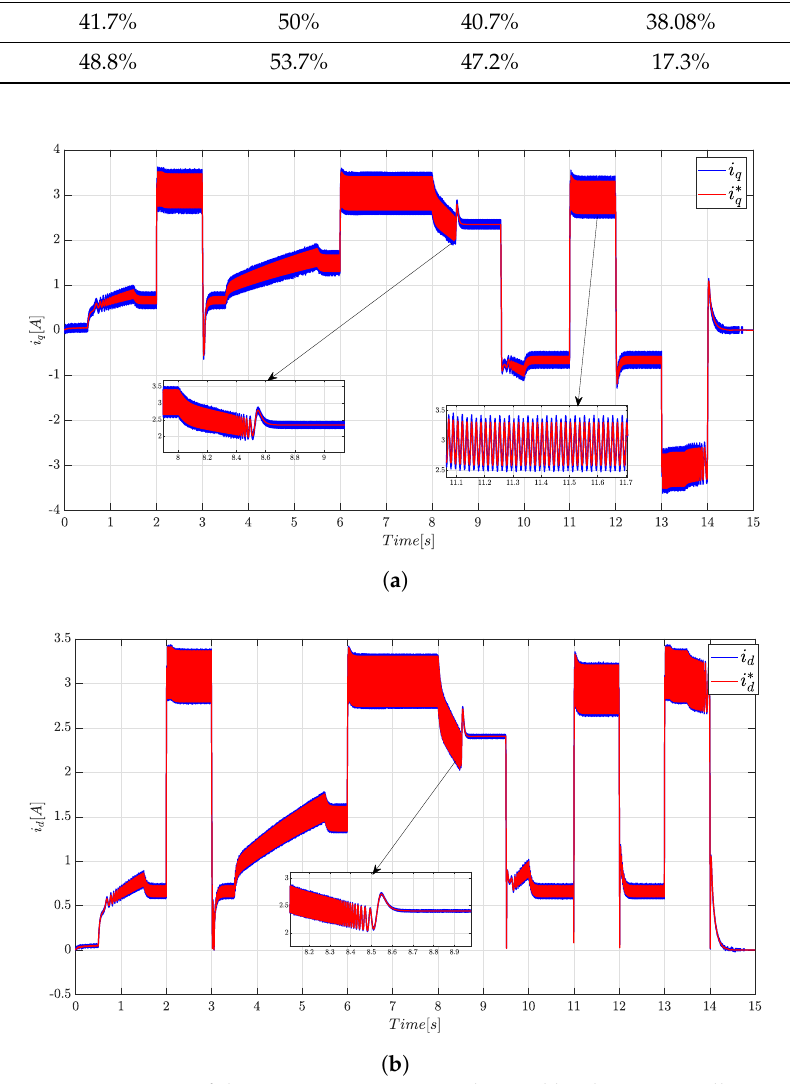
Figure 13. Response of the current components obtained by the PI controllers and optimal currents calculations method: ( a ) i q response and ( b ) i d